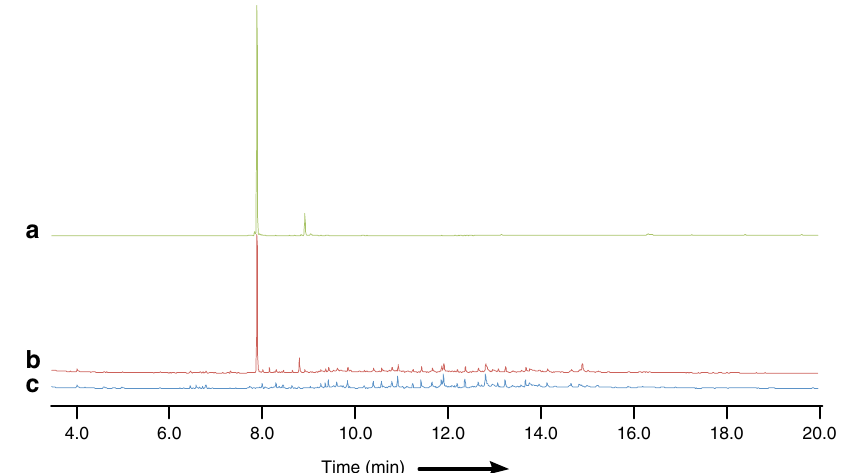
Fig. 5 GCMS analysis of AsR6 activity (total ion current, arbitary units) of pentane extracts of in vitro assays. a Humulene (Sigma-Aldrich); b AsR6 +